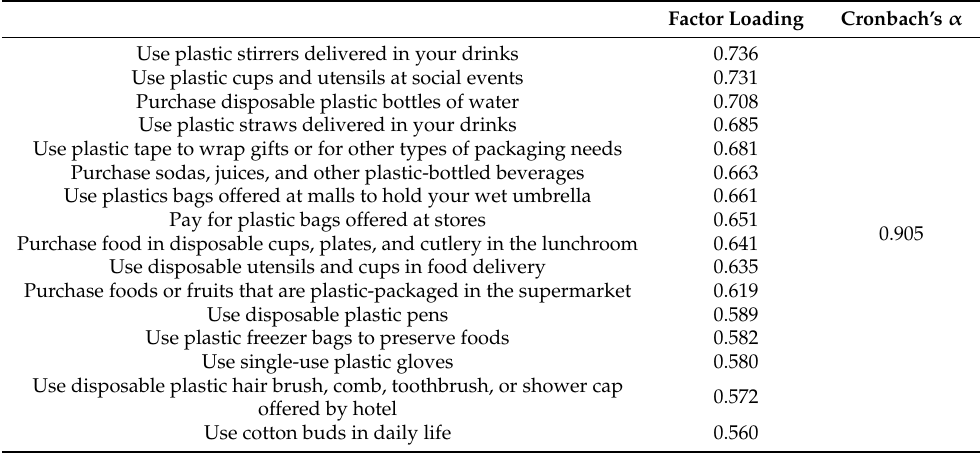
Table 1. Factor analysis of single-use plastics